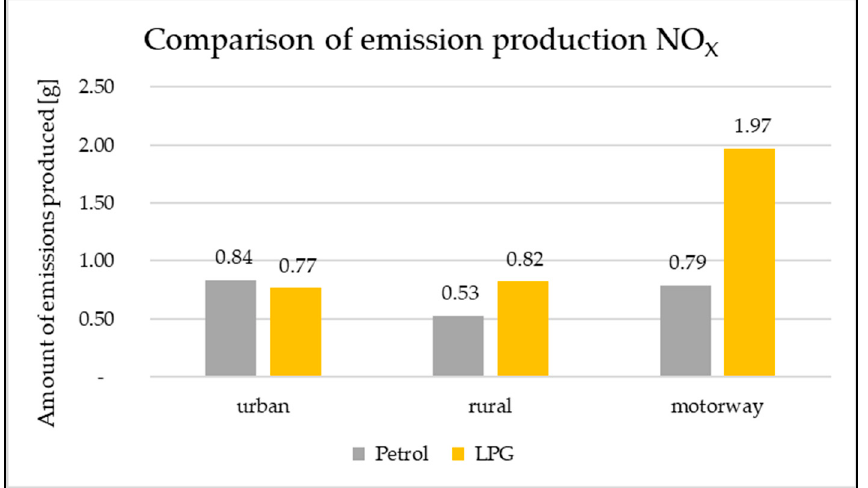
Figure 14. Comparison of HC production [measurement results processed by the author].